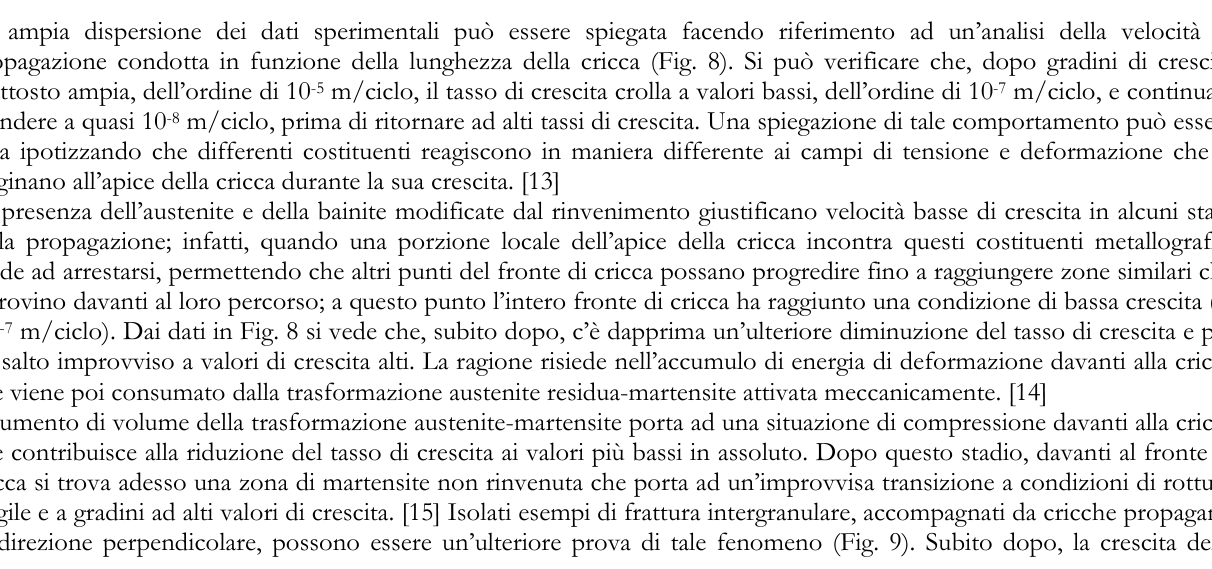
Figura 7: Risultati di prove di propagazione effettuate su campioni di acciaio 1.2738 a struttura mista costituita da martensite rinvenuta, bainite ed austenite residua modificate dal rinvenimento. Figure 7: Fatigue crack propagation rate tests of 1.2738 steel specimens with a mixed microstructure formed by tempered martensite, as well as bainite and residual austenite modified by